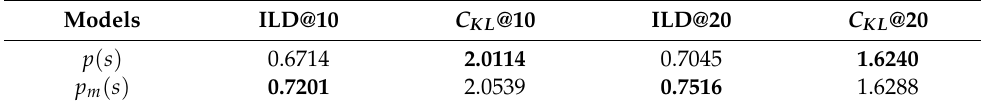
Figure 5. Illustration of amplified main interest. Table 7. The performances of distribution p m ( s ) on the Tmall